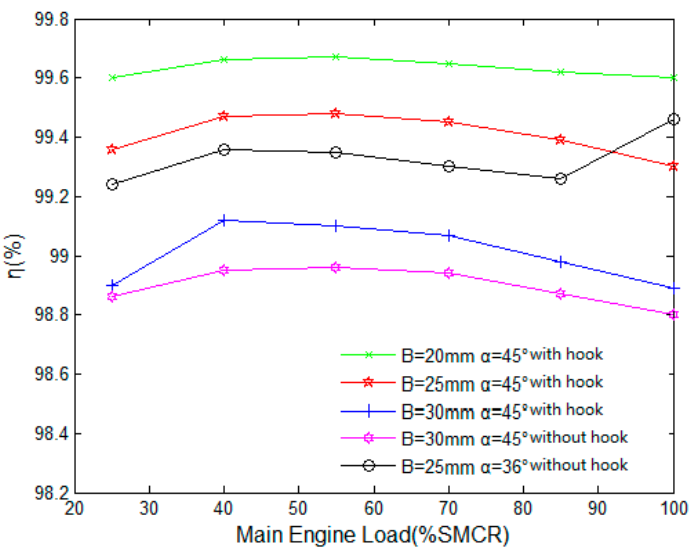
Figure 7. Influence of corrugated plate spacing on the separation efficiency.